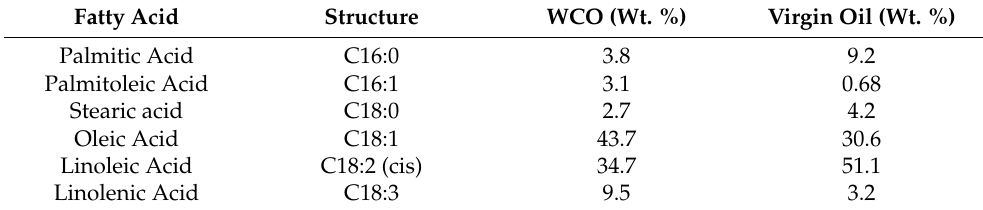
Table 2. The fatty acid weight concentration of Virgin Oil and collected